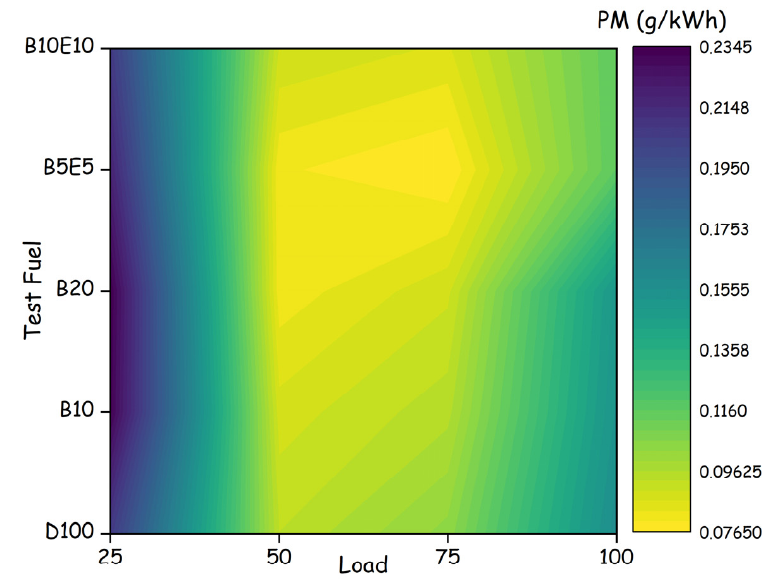
Figure 14. Variation in PM emissions of tested fuel blends against engine load.